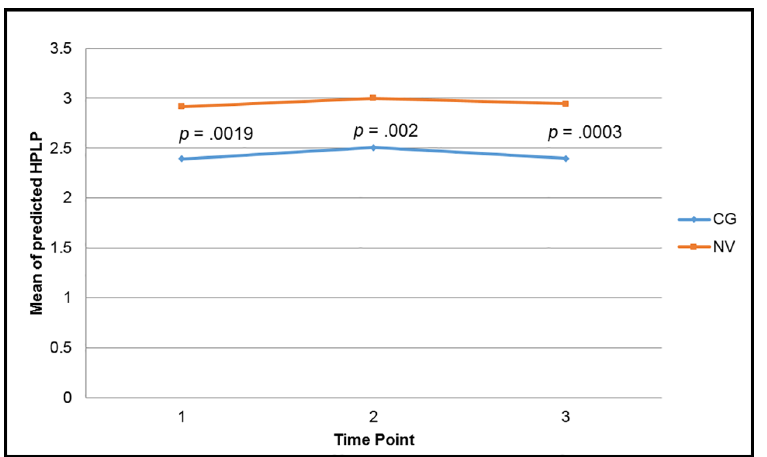
Fig 4. Predicted total scores of HPLP-II over time based on caregiverstatus. CG caregiver, NV normal